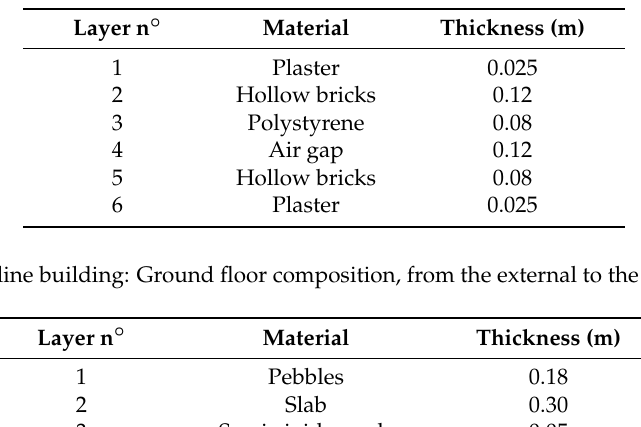
Table 1. Baseline building: External walls composition, from the external to the internal layer.